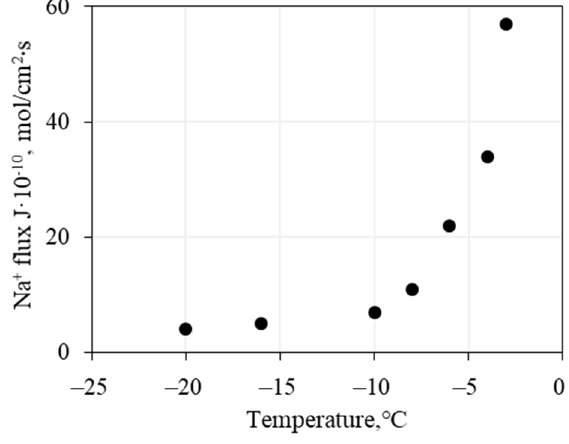
Figure 4. Average Na + flux to a frozen hydrate-bearing sample for 4 h of interaction with a 0.1 N NaCl solution, at 0.1 MPa.